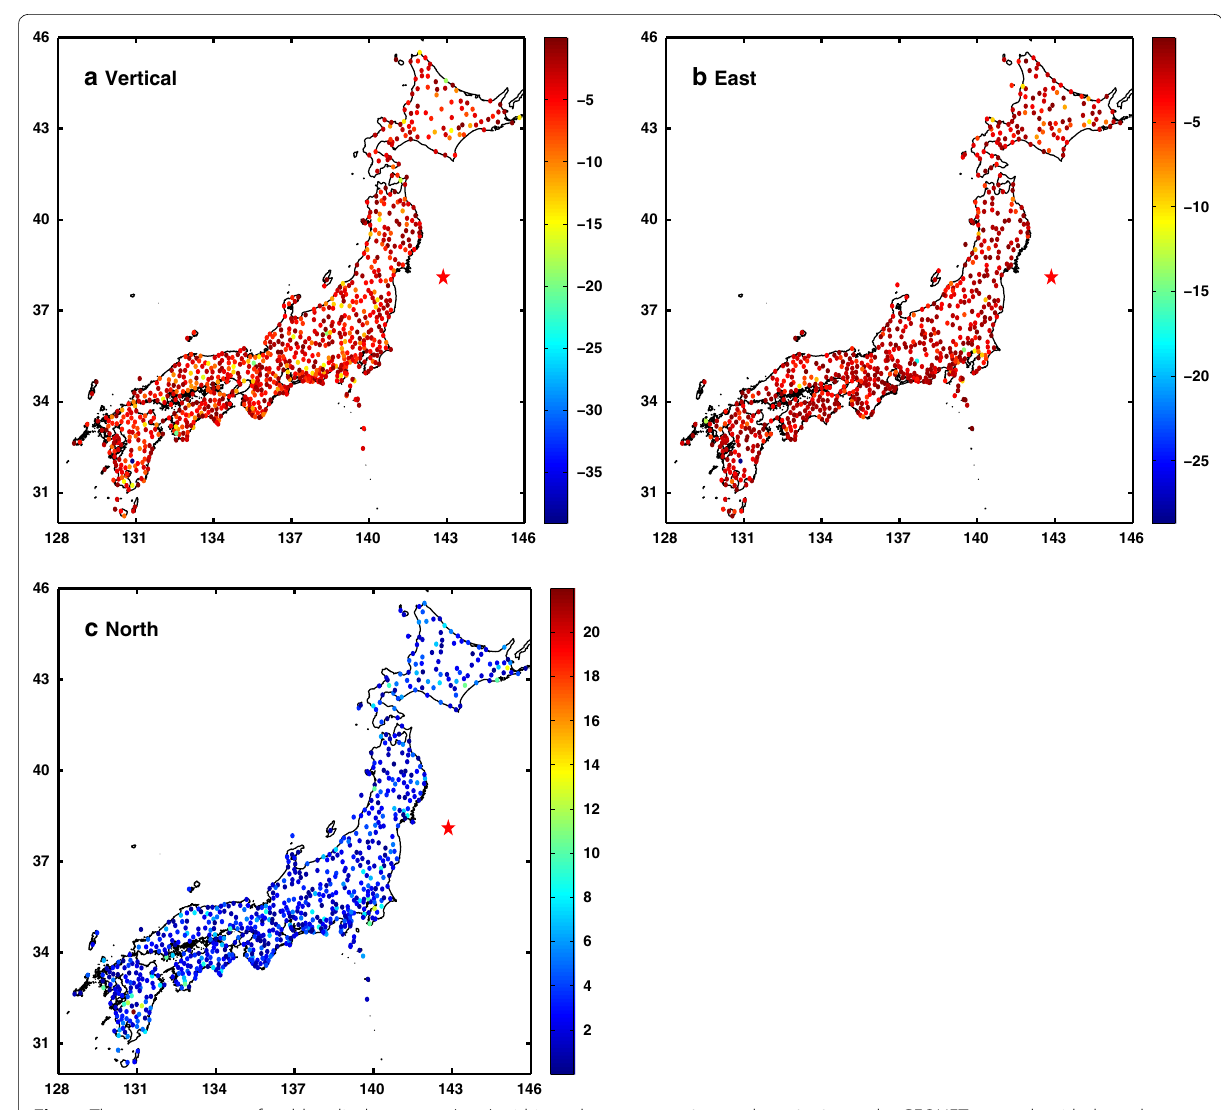
Fig. 1 Three components of sudden displacements (mm) within 1 s between 14:59:45 and 14:59:46 over the GEONET network, with the red star showing the epicenter of the 2011 Tohoku earthquake: panel a —the vertical displacements of the GEONET stations that move downward; panels b and c —the displacements of the GEONET stations that move in the east and north